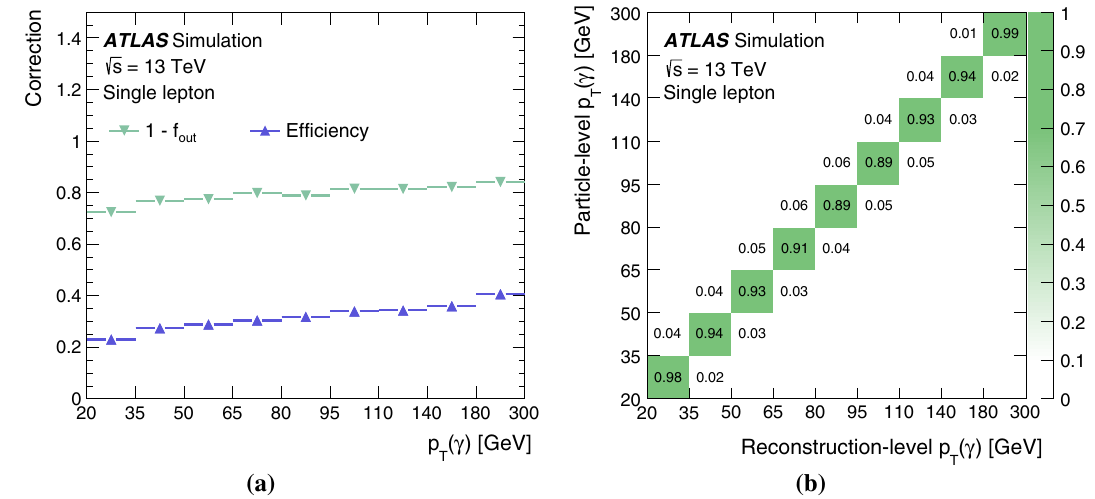
Fig. 6 The a efficiency and outside fraction and b migration matrix for the photon p T in the single-lepton channel